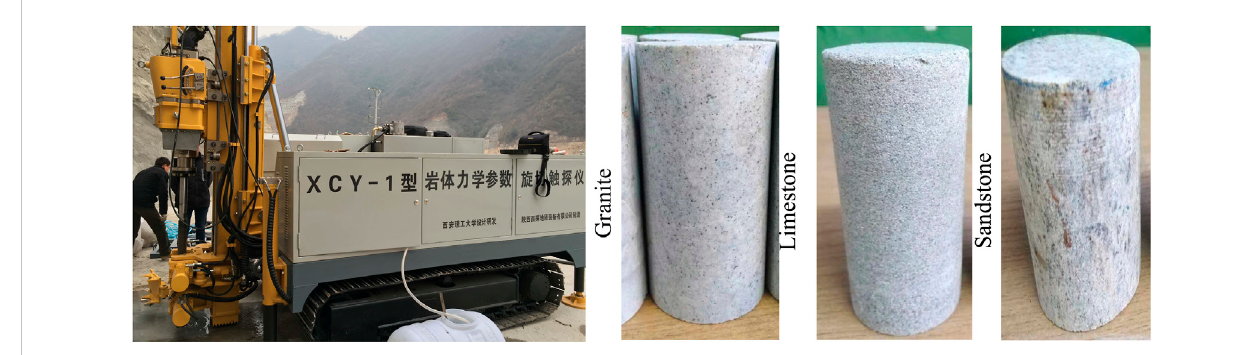
FIGURE 3 An overview of the drilling process monitoring apparatus (DPM) and part of drilled rock